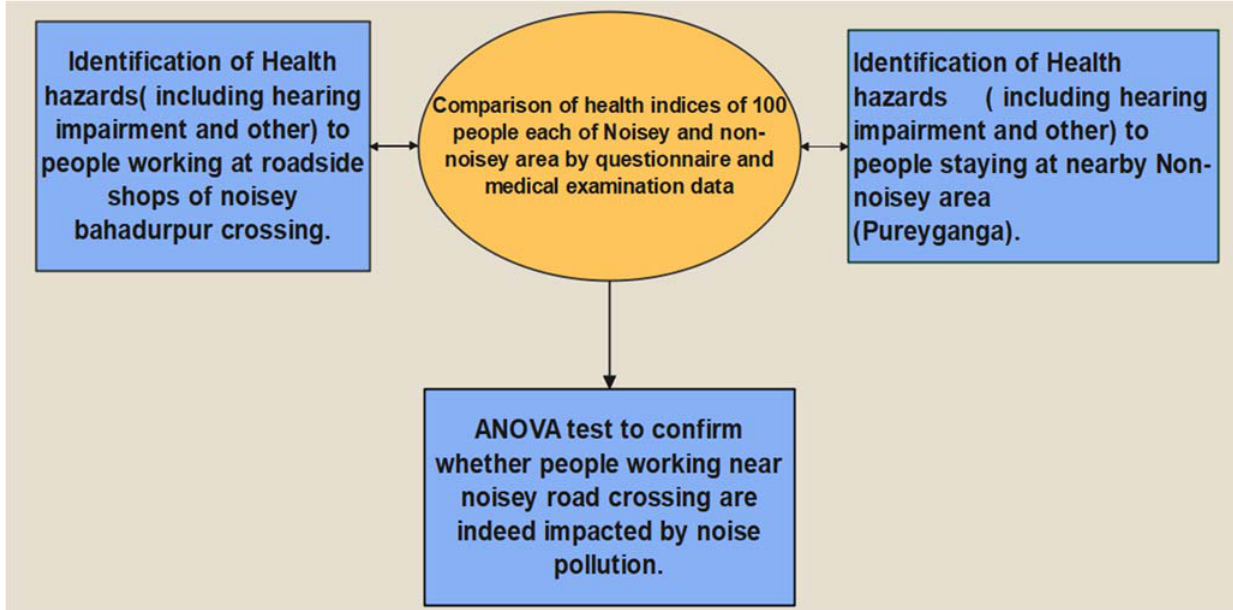
Figure 12. Identification and comparison of health hazards for noisy and less noisy intersections.